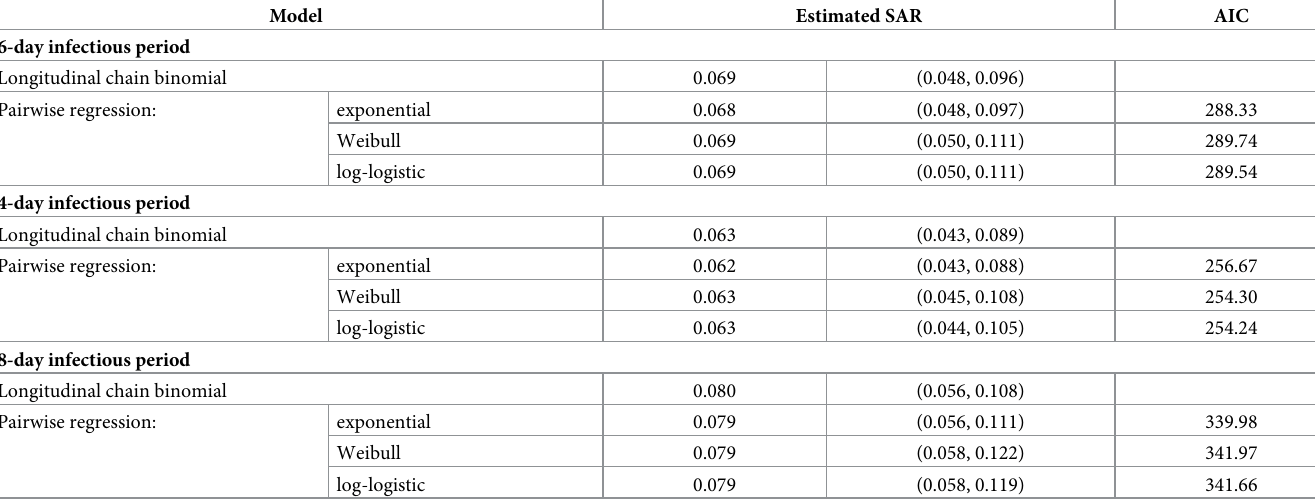
Table 4. Full-data estimates of the household SAR with 95% confidence limits and Akaike information criterion (AIC) for pairwise regression